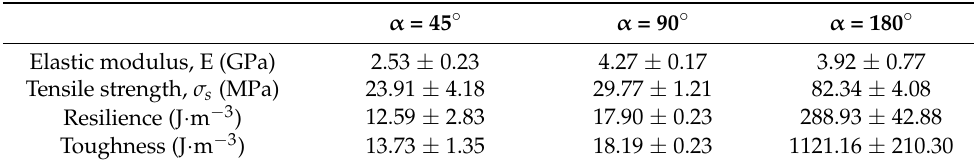
Table 2. Tensile properties of samples without heat treatment for α = 45°, α = 90° and α = 180° (nozzle diameter, 0.6 mm).